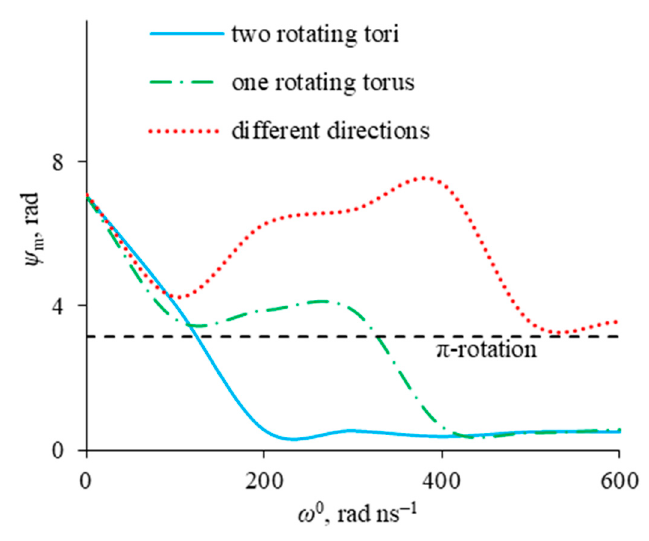
Figure 9. The maximum absolute value of the angle ψ at S = 2.